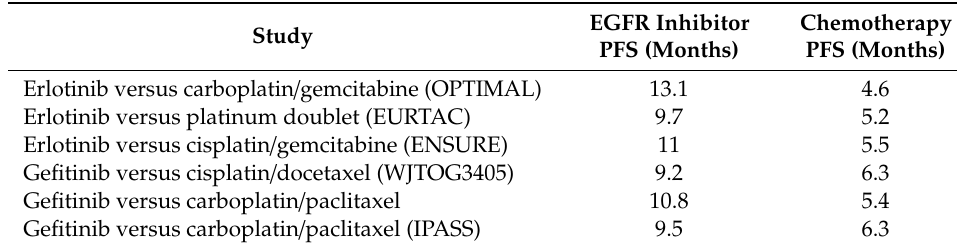
Table 1. Outcome of first-generation epidermal growth factor receptor (EGFR) tyrosine kinase inhibitors in the first-line setting. PFS, progression-free